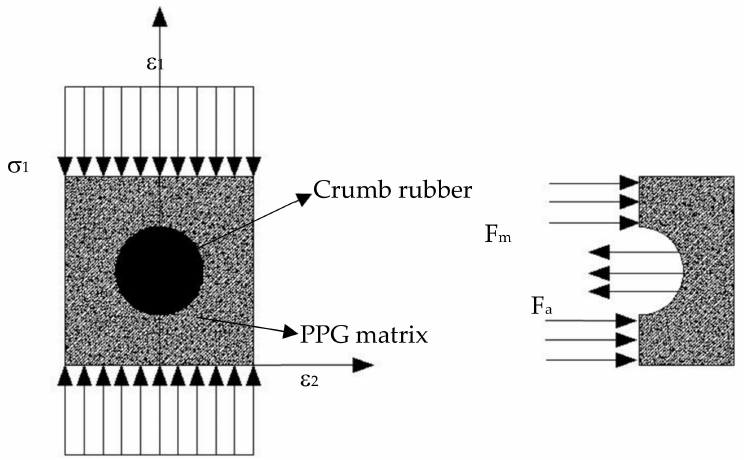
Figure 2. Uniaxial compression schematic diagram of crumb rubber